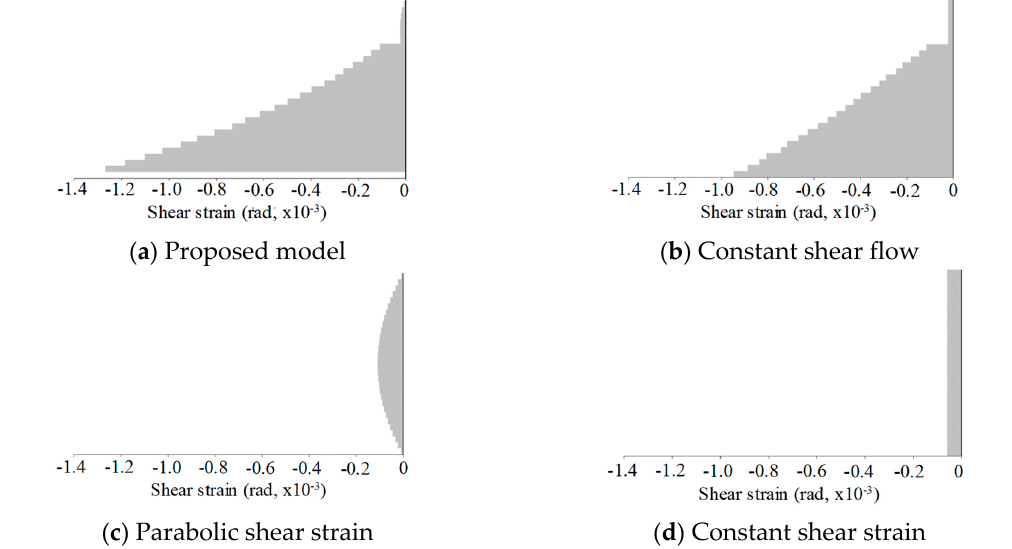
Figure 13. Shear strain distribution over cross section (at critical section, V = 54.7 kN).